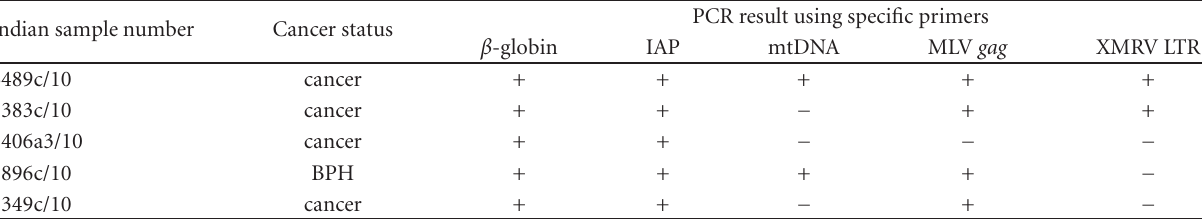
(b) Specific PCR results from Indian samples